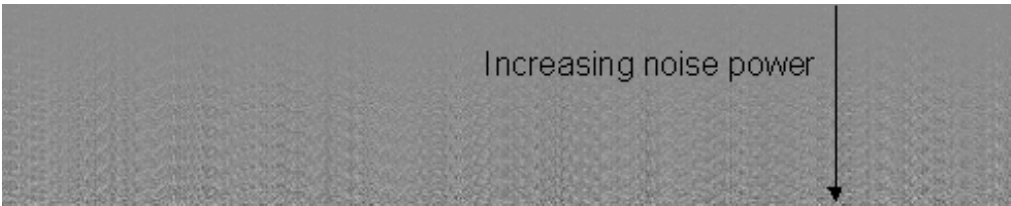
Figure 11. Synthetic image